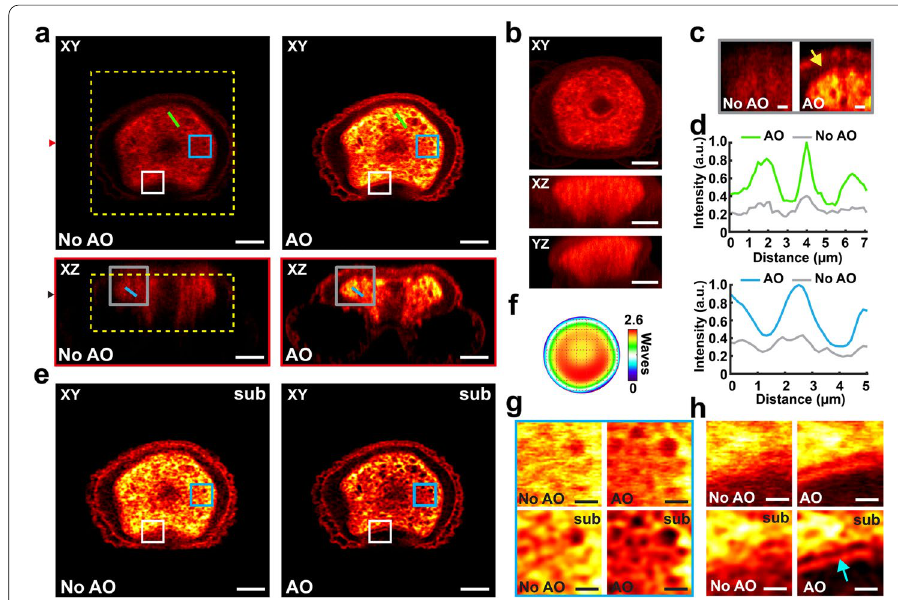
section and the lateral section with respect to each other. The yellow dashed boxes indicate the positions of the structures used for aberration measurement. b Maximum intensity projection of the structures with which the aberration was measured. c Zoomed-in views of the gray boxes in ( a ). The yellow arrow indicates the gap between the exine and body of the pollen. d Intensity profiles along the green and blue lines